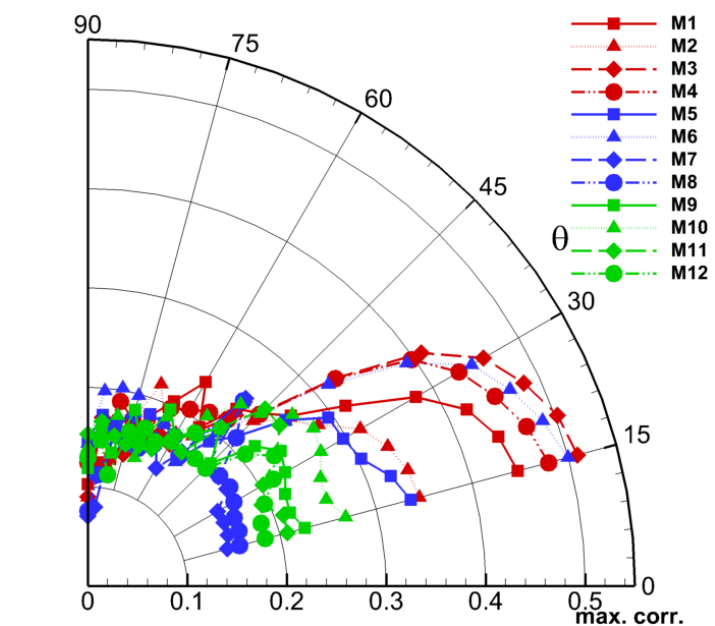
Figure 14. Maximum cross-correlation values between the time coefficients of the first 12 POD modes of the acoustic wavepacket, and the farfield acoustic signal rerecorded at various polar angles at a distance of 75 jet